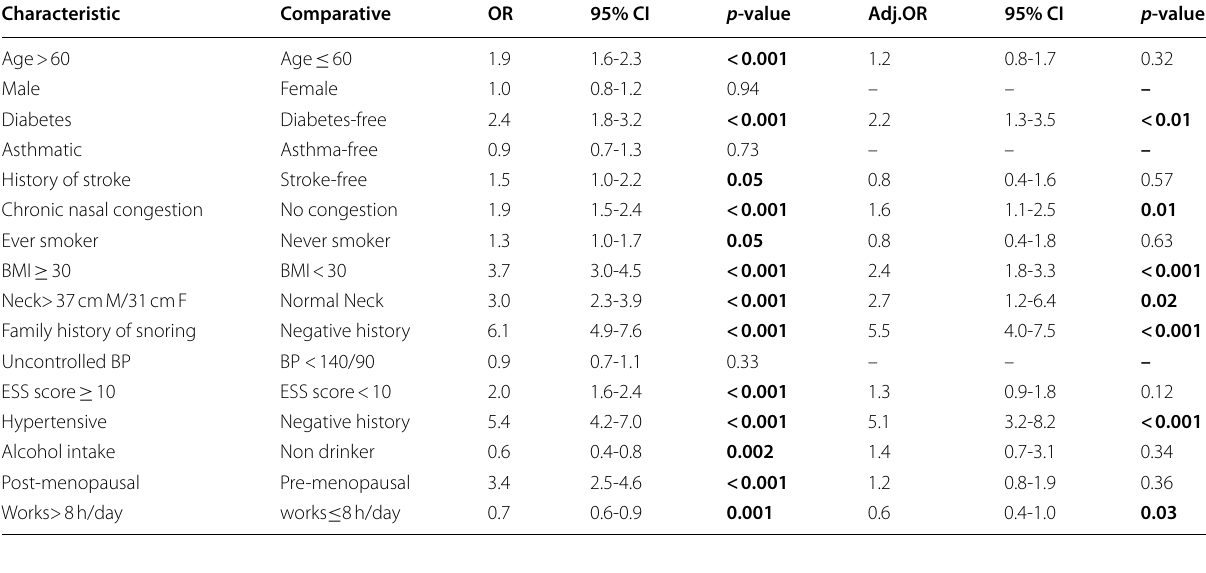
Table 4 Logistic regression analyses for factors associated with OSA Characteristic